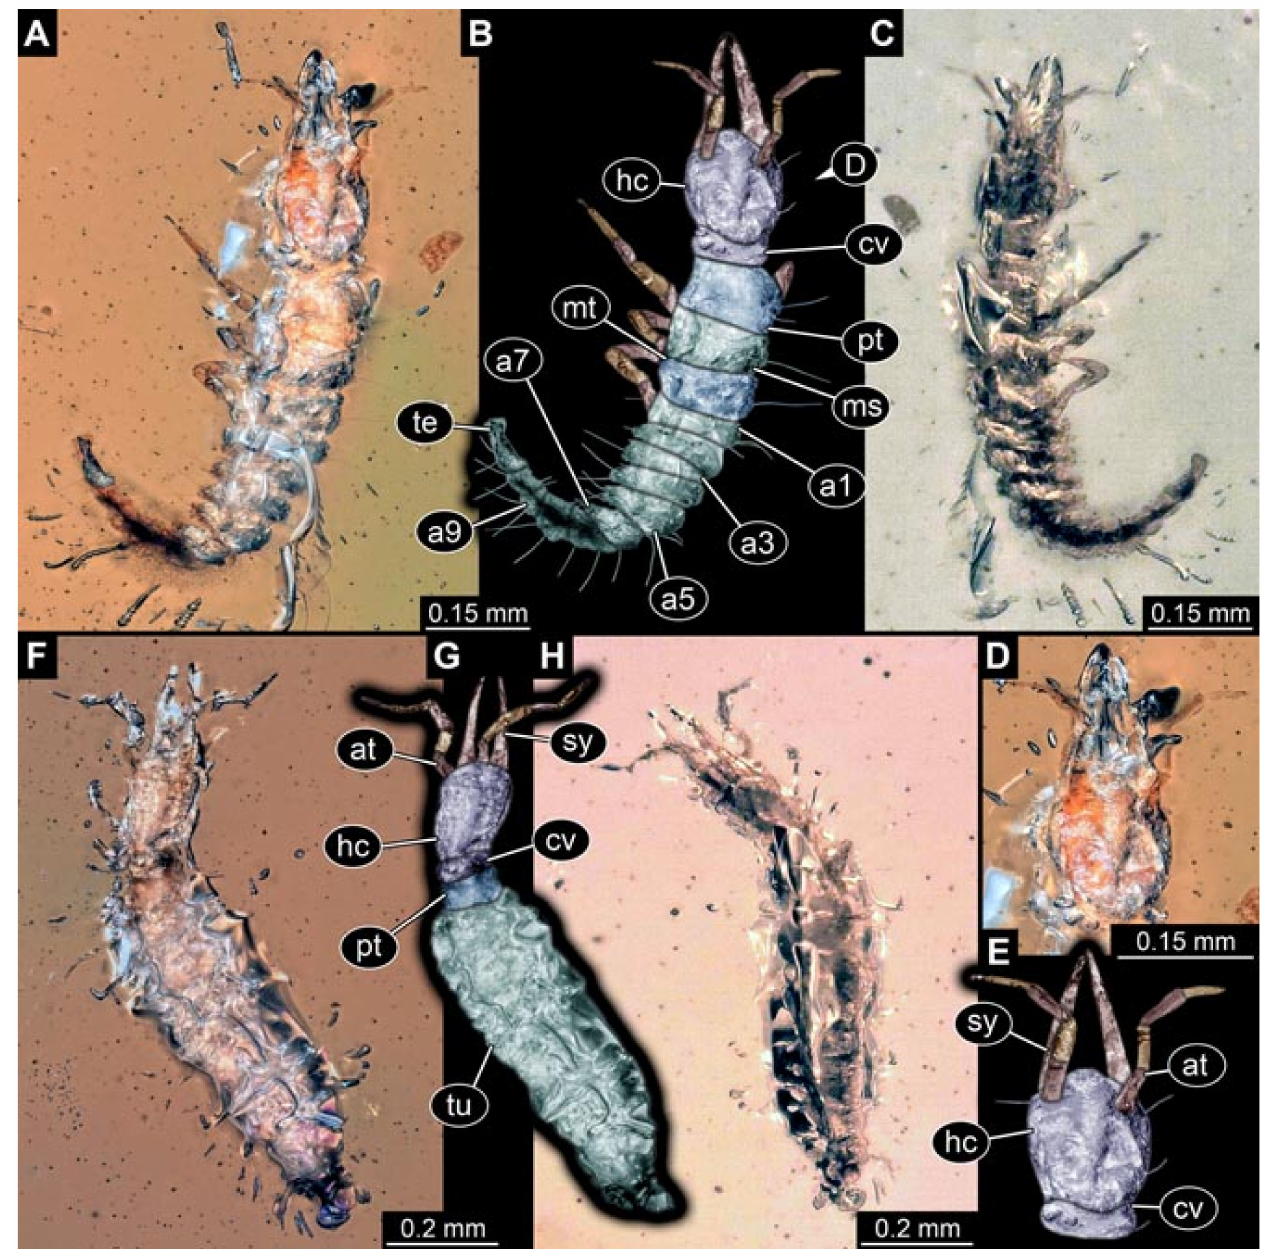
Figure 14. Specimens in Myanmar amber. ( A – E ) Specimen 5837 (PED 0772-1). ( A ) Dorsal view. ( B ) Dorsal view, colour- marked. ( C ) Ventral view. ( D ) Close-up of head in dorsal view. ( E ) Close-up of head in dorsal view, colour-marked. ( F – H ) Specimen 5838 (PED 0772-2). ( F ) Dorsal view. ( G ) Dorsal view, colour-marked. ( H ) Ventral view. Abbrevia- tions: a1–a9 = abdomen segment 1–9; at = antenna; cv = cervix; hc = head capsule; ms = mesothorax; mt = metathorax; pt = prothorax; sy = stylet; te = trunk end; tu =